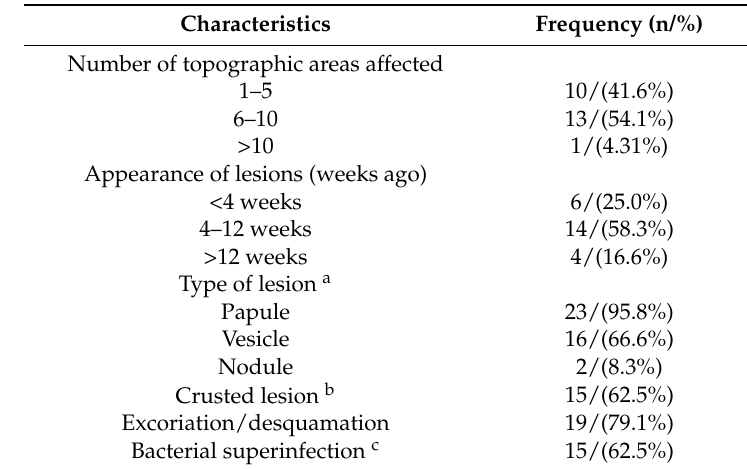
Table 2. Clinical characteristics of 24 patients with scabies.